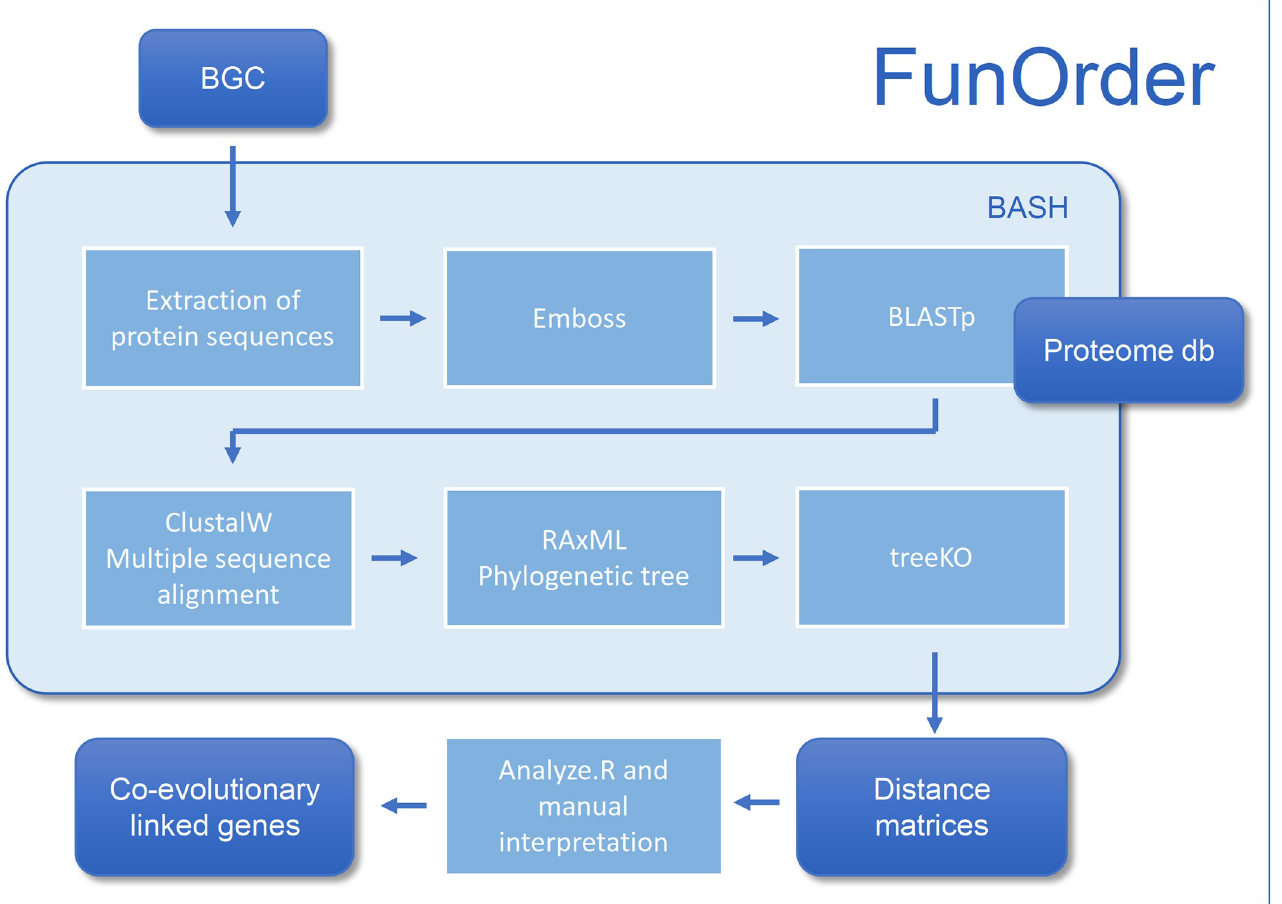
Fig 2. Schematic representation of the workflow of